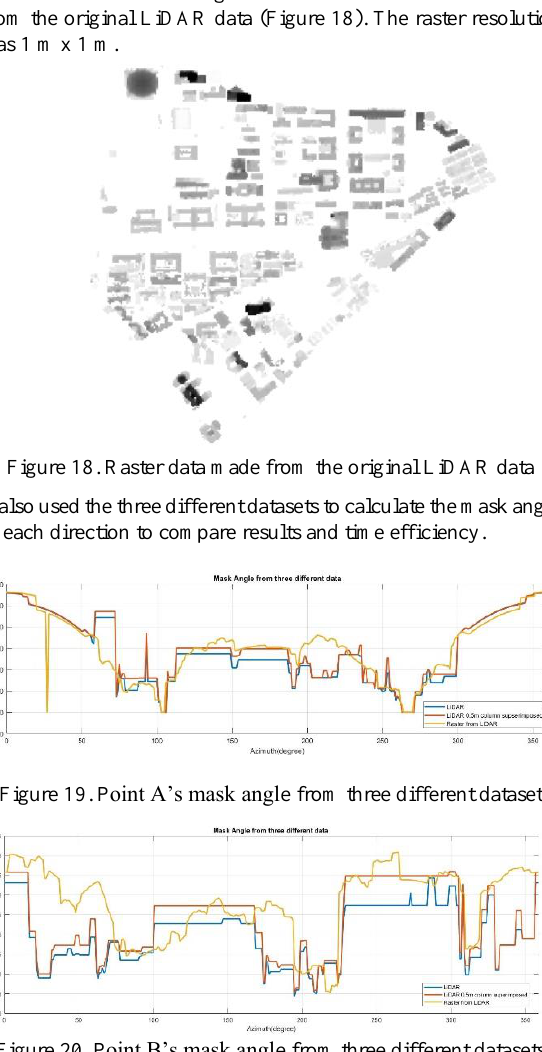
Figure 17 . Skyplot of point B